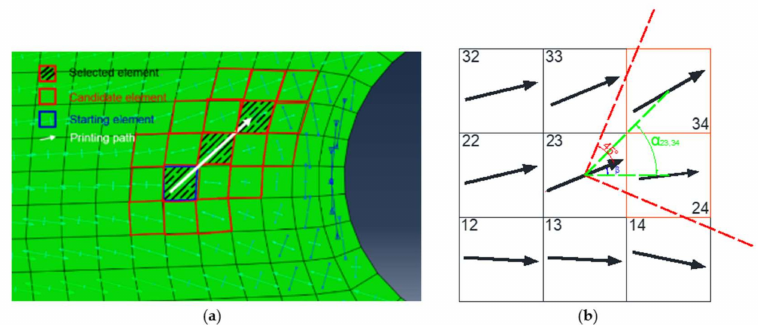
Figure 13. ( a ) Concept of elemental printing path connection; ( b ) concept of angle di ff erence filtering.